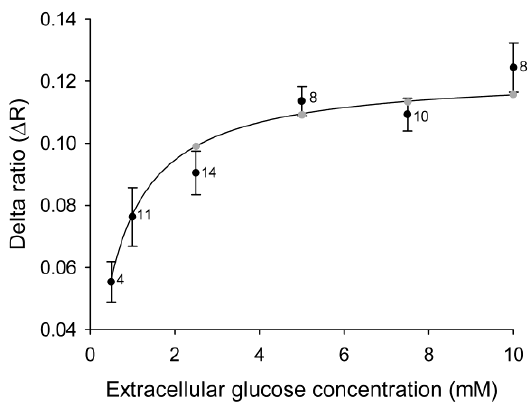
Figure 2. Cytosolic glucose levels in 3T3-L1 cells increase with increasing concentrations of extracellular glucose. Mean delta ratios (Δ R ) reflect the cytosolic glucose levels in 3T3-L1 cells incubated with different concentrations of extracellular glucose. Each cell was incubated with 1–5 different glucose concentrations separated by 5-min wash periods without glucose, and the delta ratios were calculated as the difference between the average YFP/CFP ratios during incubation with and without glucose. The curve represents the best fit obtained by non-linear regression of the equation Δ R = (Δ R with the gray symbols denoting the predicted Δ R at the extracellular glucose concentrations used in the experiments. The numbers adjacent to the symbols indicate the number of measurements of the explicit extracellular glucose concentration obtained from cells subjected to alternating extracellular glucose